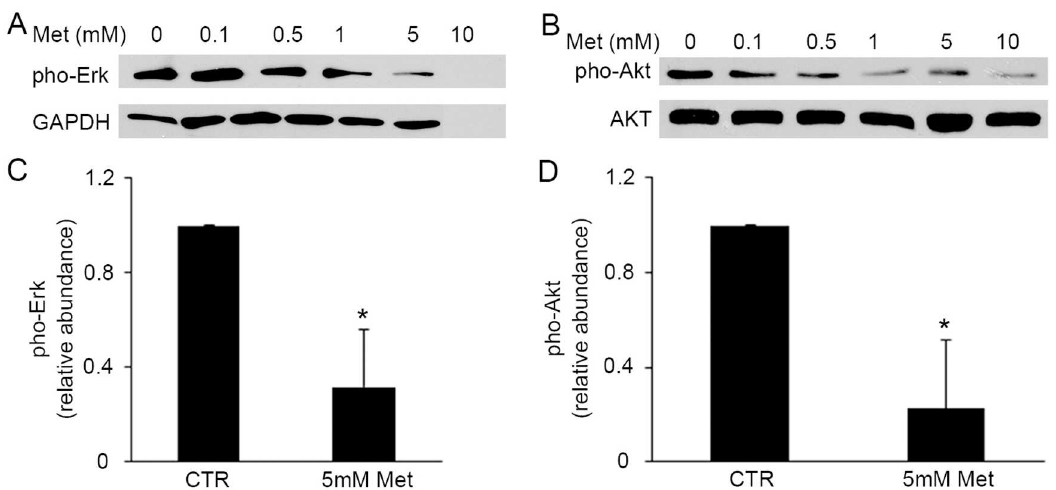
Fig 4. Metformin inhibits the expression of cell proliferating regulators, Erk and Akt. A-B: Representative immunoblot of three different experiments of pho-Erk(A) and pho-Akt protein levels (B) in BPH-1 cells 48h after